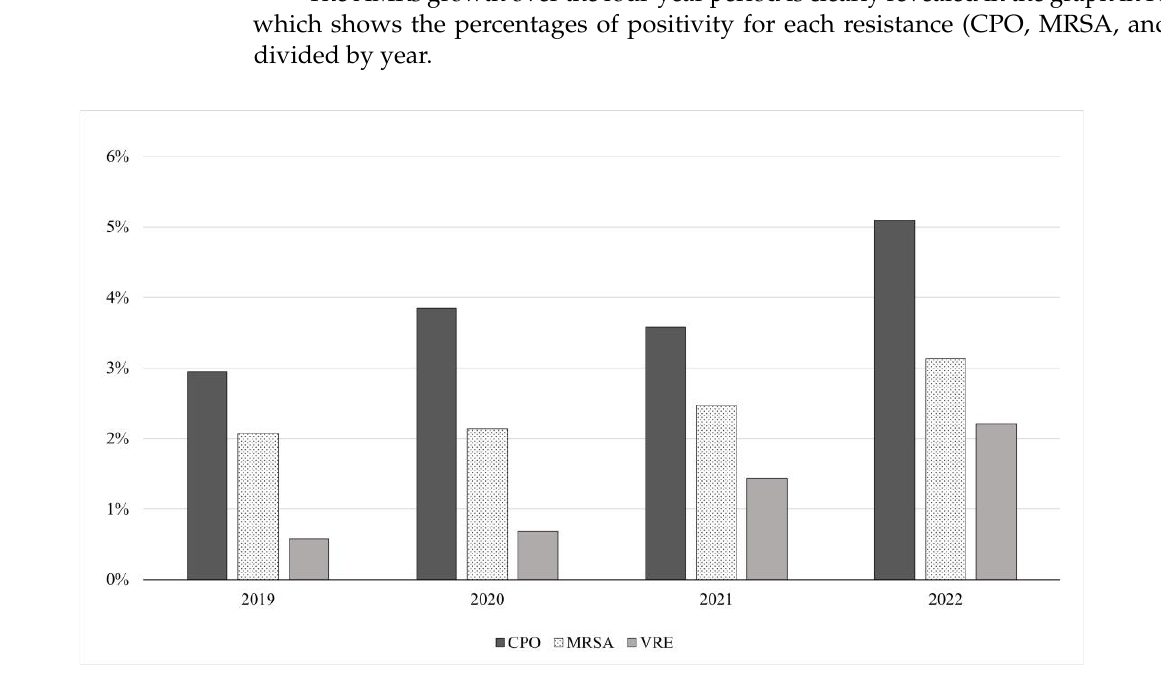
Figure 1. Percentages of positivity for each resistance (CPO, MRSA, and VRE), divided by year. Figure 2 describs the AMRs trend during the study period divided by bacterial spp.